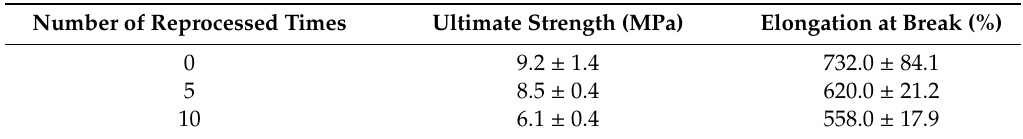
Table 4. Tensile properties of samples prepared via the Split-DV method (sTPV) after 0, 5, and 10 reprocessed